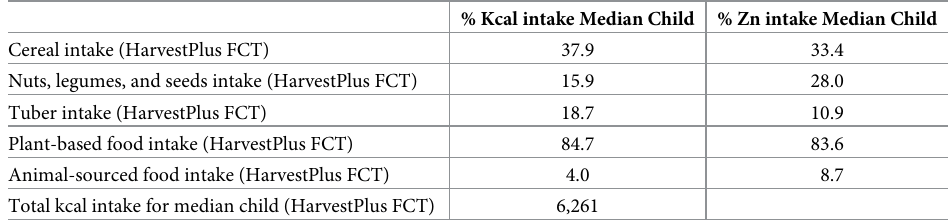
Table 3. Source of calorie and Zn intake according to harvestplus FCT.